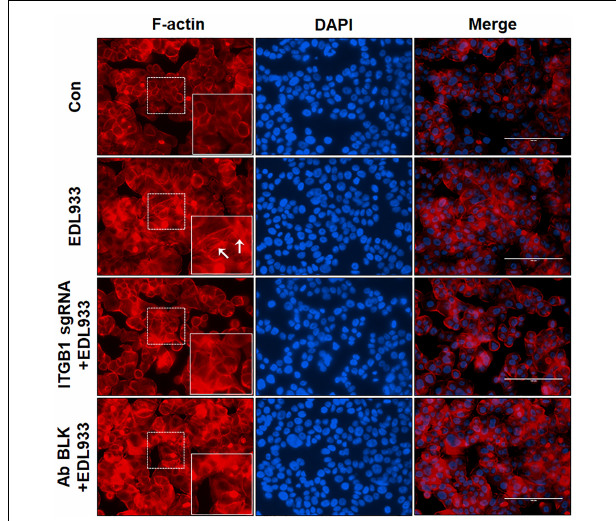
FIGURE 4 | Integrin β 1 was associated with E. coli O157:H7-mediated actin polymerization. Immunofluorescence staining for F-actin in Caco-2 cells. Caco-2 cells were immuno-blocked with integrin β 1 antibody (Ab BLK) or transfected with integrin β 1 sgRNA (ITGB1 sgRNA) plasmid followed by infection with EDL933 strain for 4 h. Cells were then subjected to phalloidin-TRIC staining. Con, Caco-2 cells without infection; EDL933, Caco-2 cells infected with EDL933 strain. ITGB1 sgRNA + EDL933, integrin β 1 knockout Caco-2 cells infected with EDL933 strain; Ab BLK + EDL933, integrin β 1 blocked Caco-2 cells infected with EDL933 strain. Blue, DAPI; Red, F-actin; Images were taken at 200 × magnification.